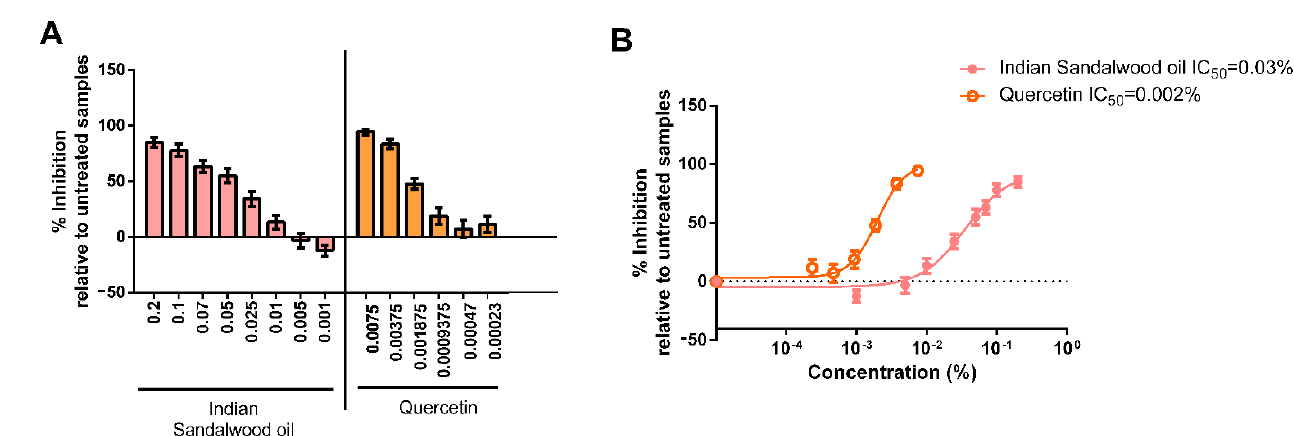
Figure 3. Assessment of ROS induced after exposure to the peroxyl radical initiator AAPH in HaCaT cells. The values represent the percentage of inhibition (mean ± SEM) compared to the respective untreated sample (treated with AAPH and DCFH-DA only). ( A ) represents bar chart representation of the results. ( B ) represents a non-linear regression curve. The results represent the mean value of three independent runs performed, and for each run, the samples were tested in triplicates.